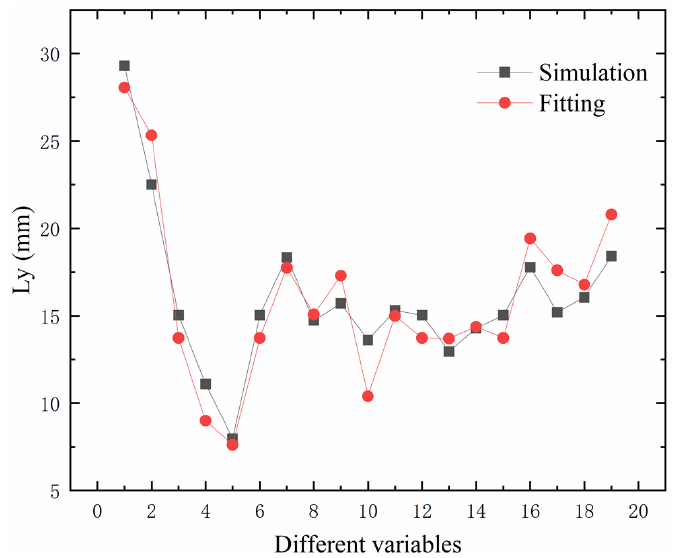
Figure 10. Comparison between fitting results and simulation results.